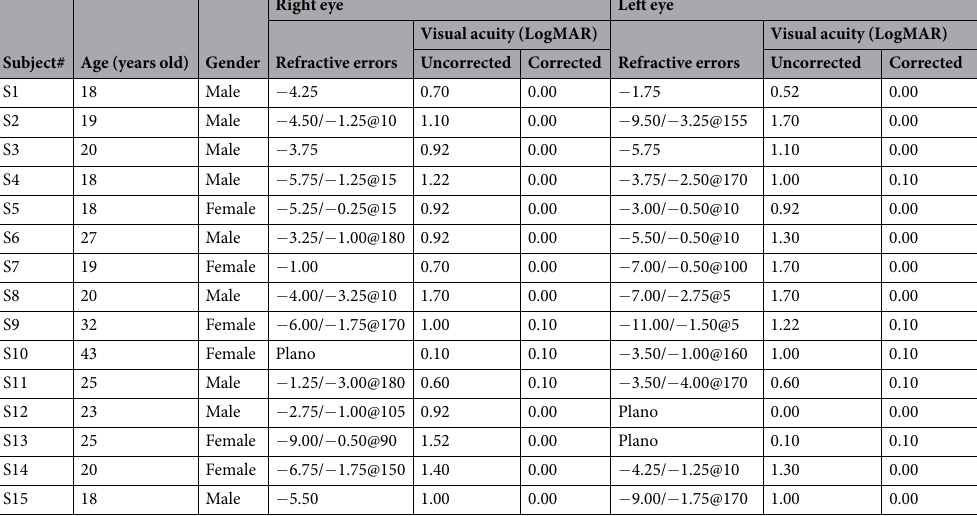
Table 1. Clinical details of the